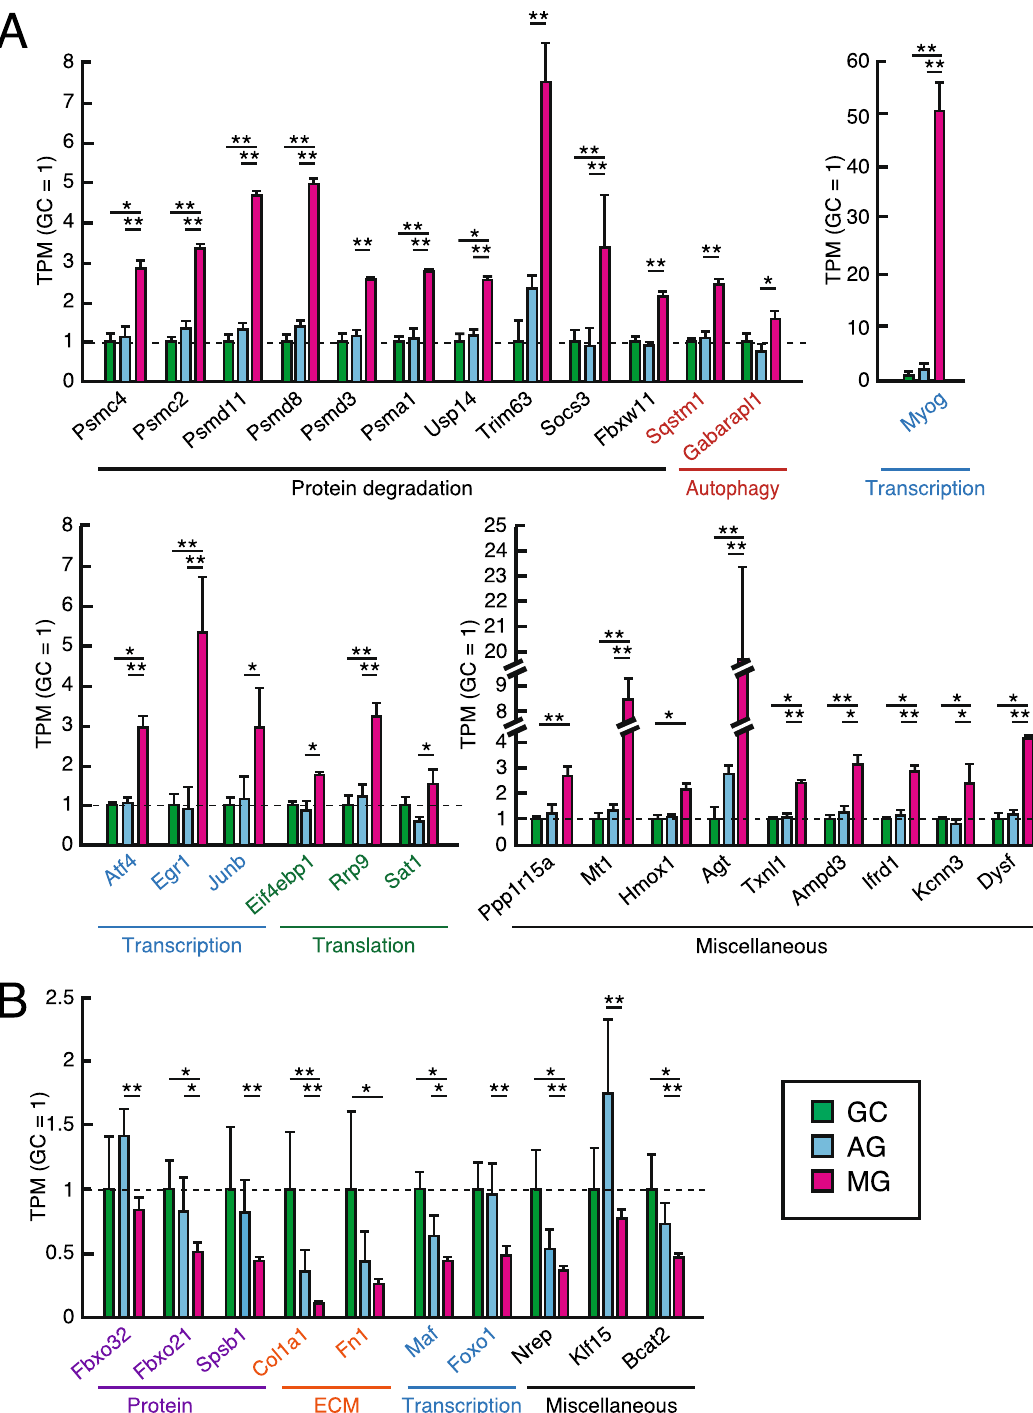
Figure 3. Differentially expressed genes of atrogenes in the soleus muscle of GC, AG, and MG. Bar diagrams showing the gene expression of atrogenes (atrophy-related genes) as significantly upregulated ( A ) and downregulated ( B ) in MG compared with GC and/or AG. FDR-corrected P -value from statistical test is indicated as follows: *FDR-corrected P < 0.05 and **FDR-corrected P < 0.01. GC (Green), AG (Blue), and MG